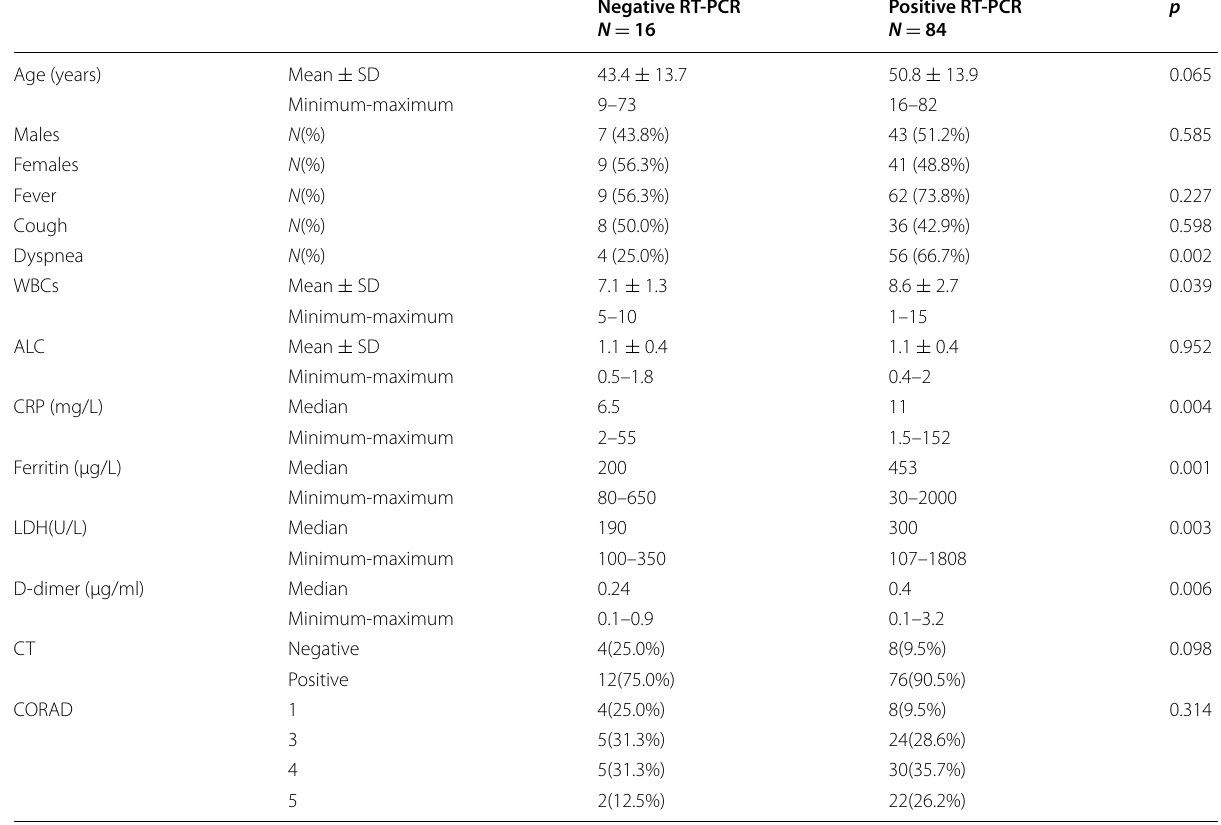
Table 4 Comparison of studied parameters between negative and positive PCR